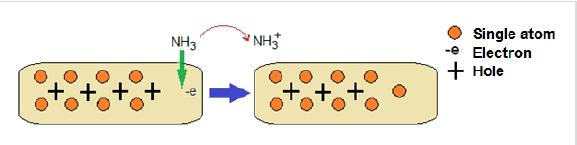
Figure 3: Schematic of the NH 3 sensing mechanism based on the gas adsorption